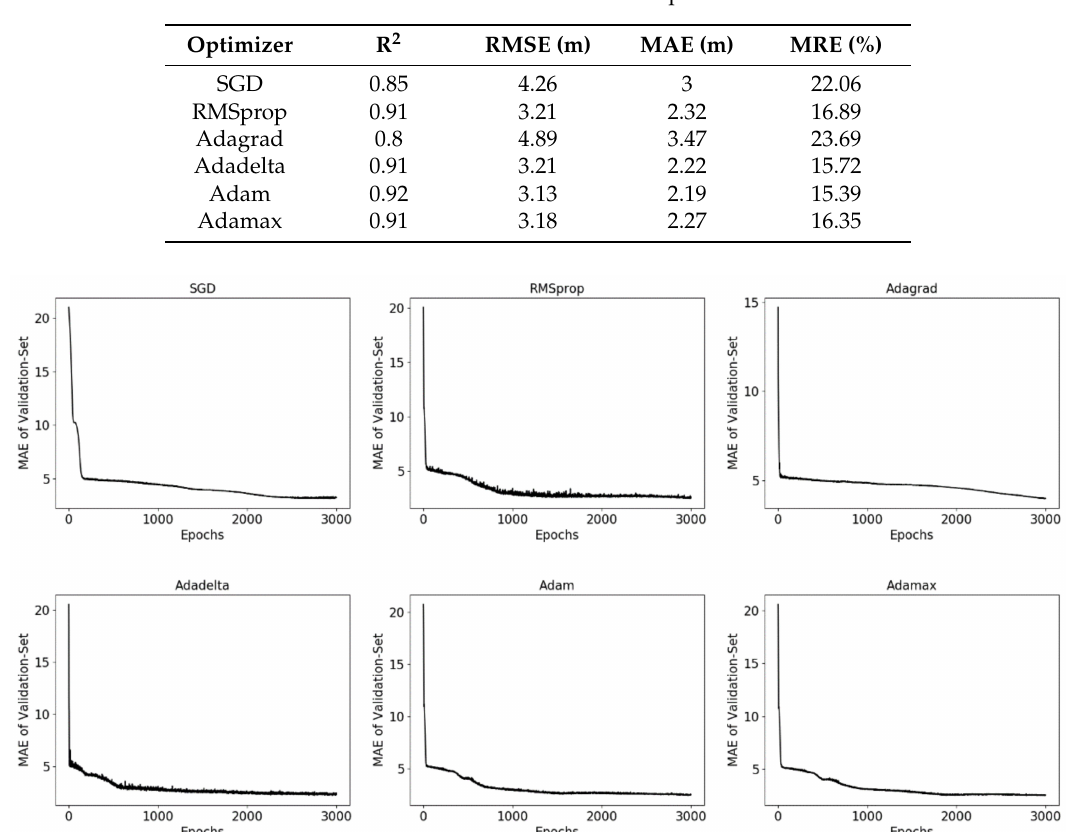
Table 4. Error statistics of di ff erent optimizers.